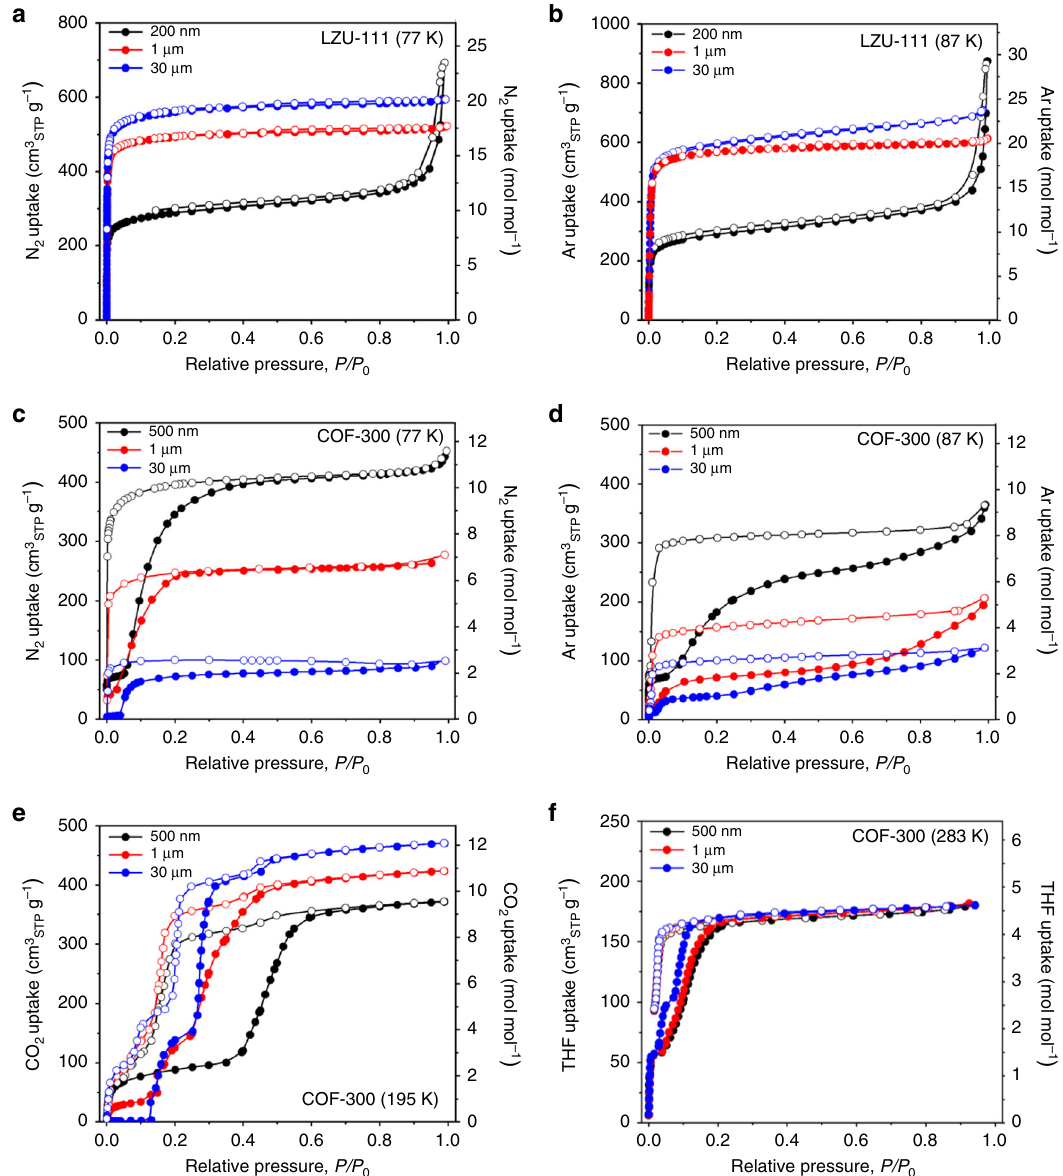
Fig. 4 Gas sorption experiments and analyses for different-sized COFs (solid circle, adsorption; hollow circle, desorption. 200 nm-sized LZU-111 and 500 nm-sized COF-300, black; 1 μ m-sized LZU-111 and COF-300, red; 30 μ m-sized LZU-111 and COF-300, blue). a , b N 2 and Ar adsorption – desorption isotherms of different-sized LZU-111, respectively. c – f N 2 , Ar, CO 2 , and tetrahydrofuran (THF) adsorption – desorption isotherms of different-sized COF-300,